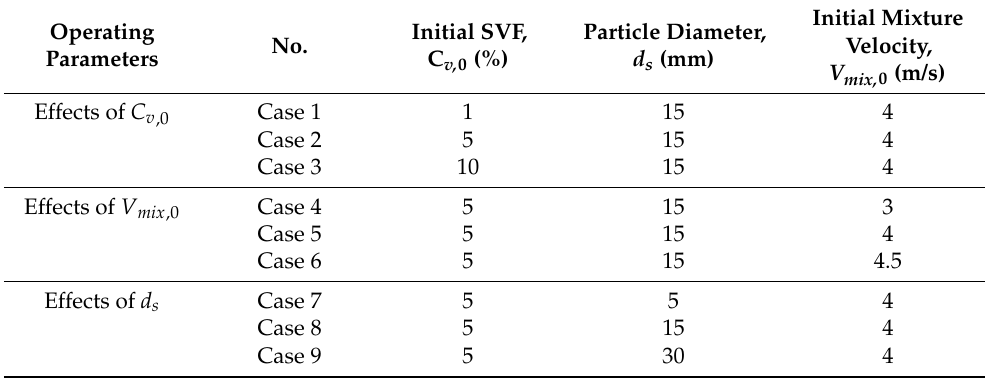
Table 2. Operating conditions for present